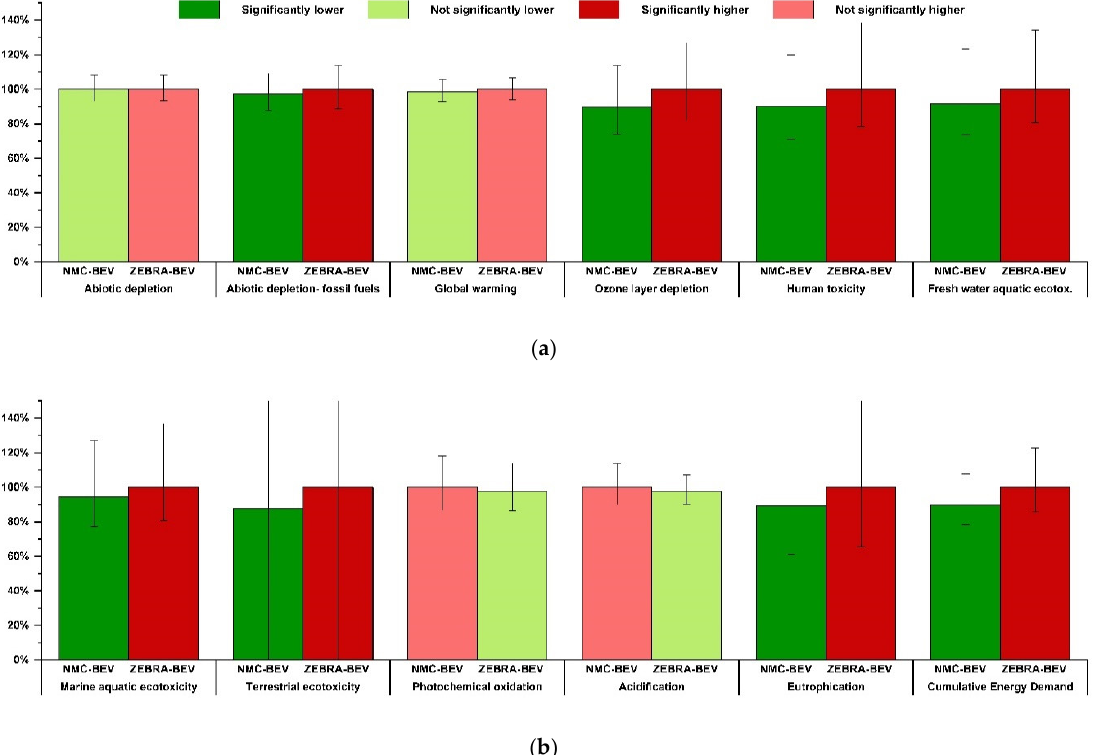
Figure A2. ( a , b ) Graphical representation of the comparison of the uncertainty range of the BEV vehicles. In this Monte Carlo analysis, the NMC-BEV is powered by 3 battery packs. Some impact categories present higher values than 140% and lower ones than